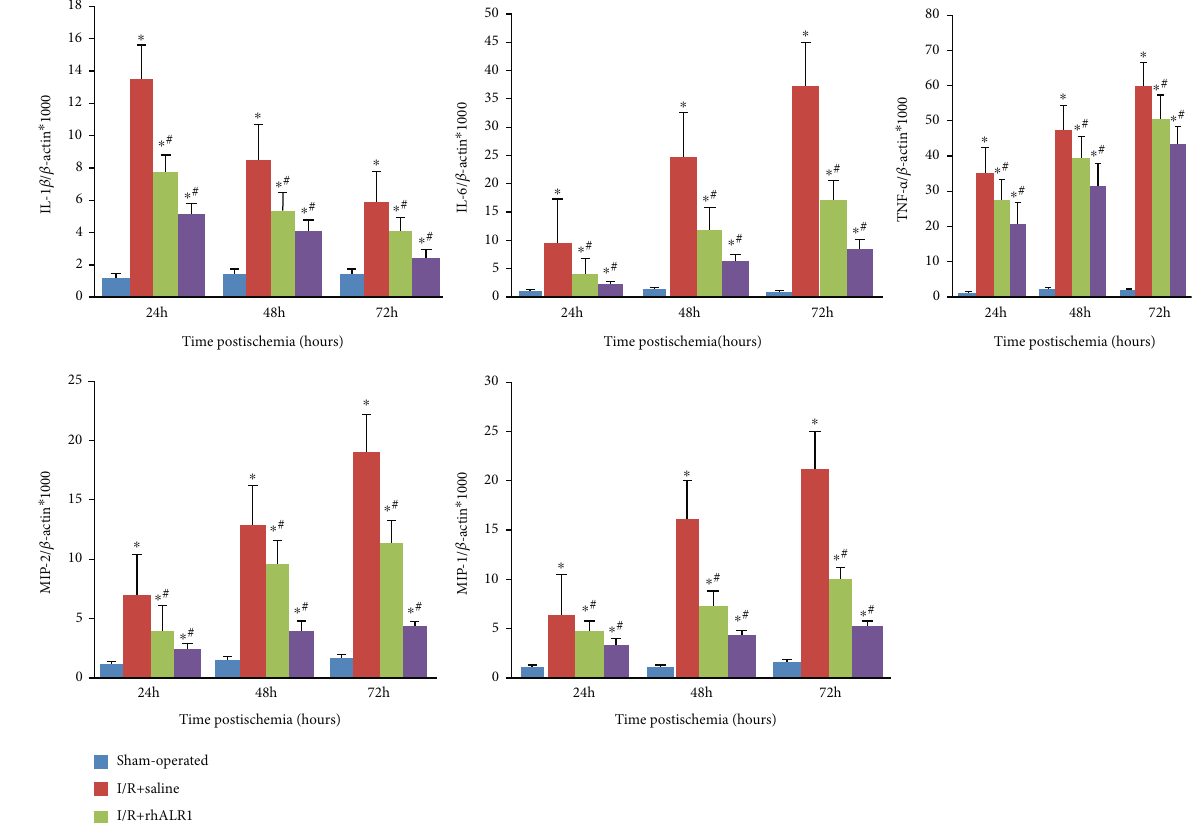
Figure 4: rhALR suppressed renal in fl ammatory cytokine and chemokine production after I/R injury. The mRNA expressions of in fl ammatory cytokines and chemokines (IL-1 β , IL-6, TNF- α , MIP-2, and MCP-1) were detected by real-time PCR at 24, 48, and 72 h after renal I/R injury treatment. All data were expressed as the mean ± SD . ∗ P < 0 : 05 vs. sham, # P < 0 : 05 vs. I/R+saline